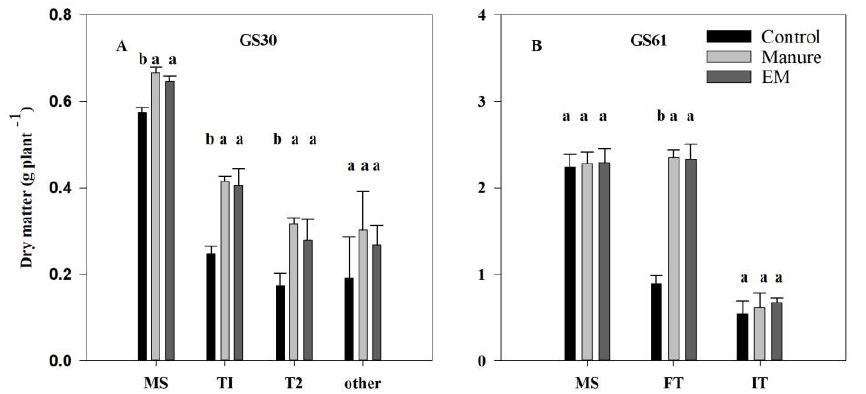
Figure 4. The dry matter of the main stem (MS), tiller1 (T1), tiller2 (T2), other tillers at GS30 (start of stem elongation stage) ( A ) and the main stem (MS), valid tiller (VT), invalid tiller (IT) at GS61 (beginning of anthesis stage) ( B ) of per plant for three treatments over 3-year study period. Means followed by the different letter means significantly different among different treatment for MS, T1, T2 VI, IT and others at p < 0.05 level. Vertical bars represent ± S.E. of the mean.